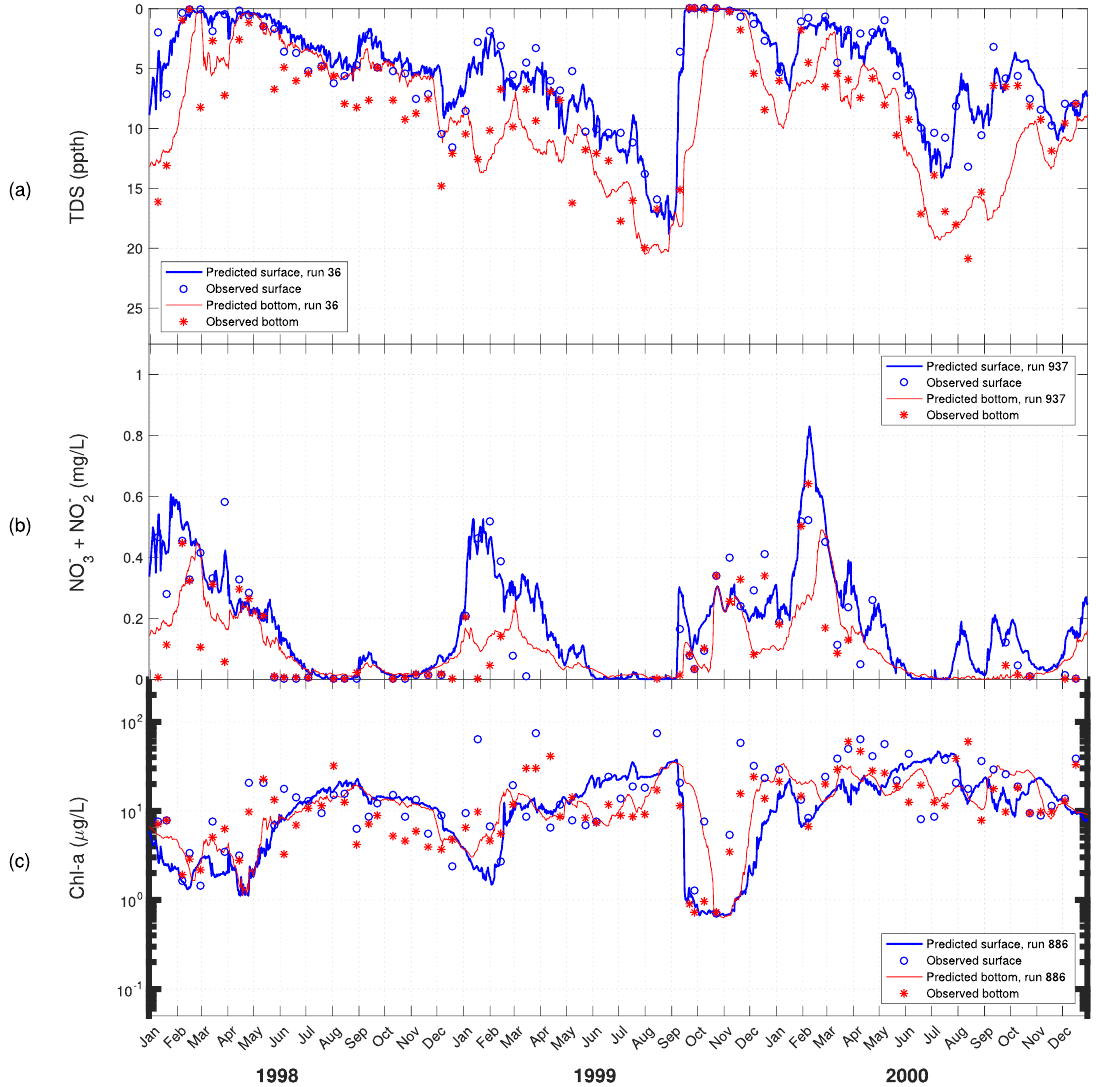
Figure 9. Time series for predicted versus observed values of: ( a ) salinity; ( b ) nitrate + nitrite; and ( c ) chlorophyll-a at ModMon 100 for 1998–2000.